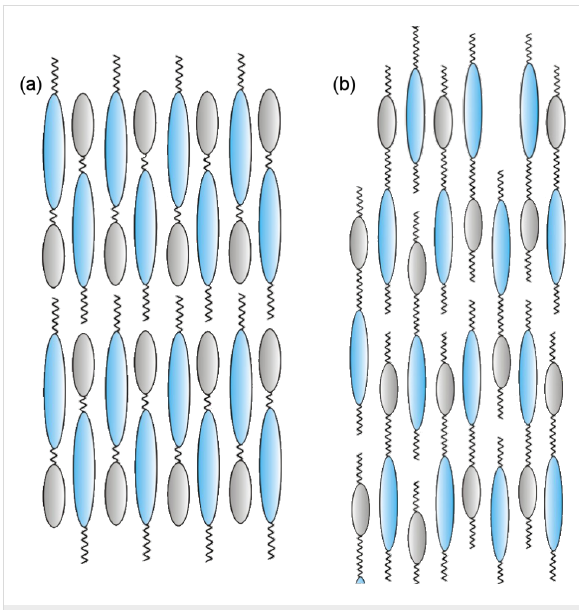
Figure 4: Models showing the suggested organizations of dimeso- gens in the smectic phases and in the preferred local structure in the cybotactic clusters of the related nematic phases: (a) monolayer struc- ture ( d ~ L ); (b) intercalated structure ( d ~ ½ L ). The molecular tilt and the bent-shape of the mesogenic units are not